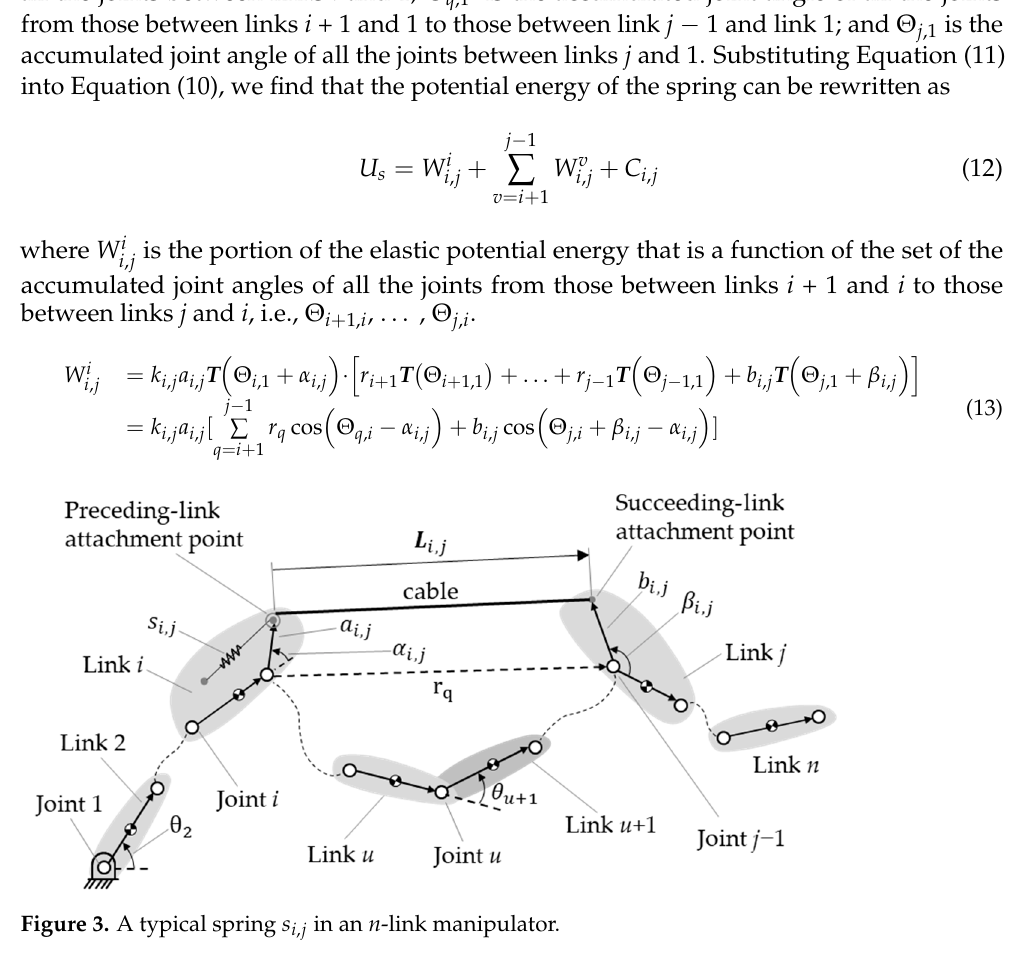
i , j in an n -link